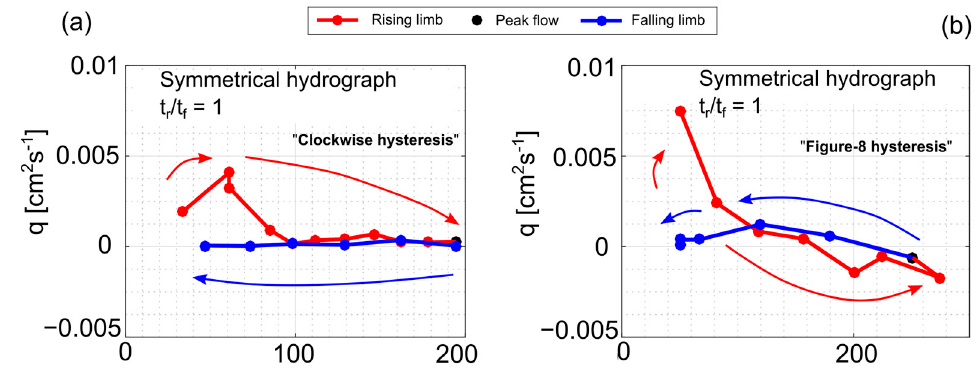
Figure 13. Hysteresis pattern: ( a ) clear water and ( b ) channel degradation.